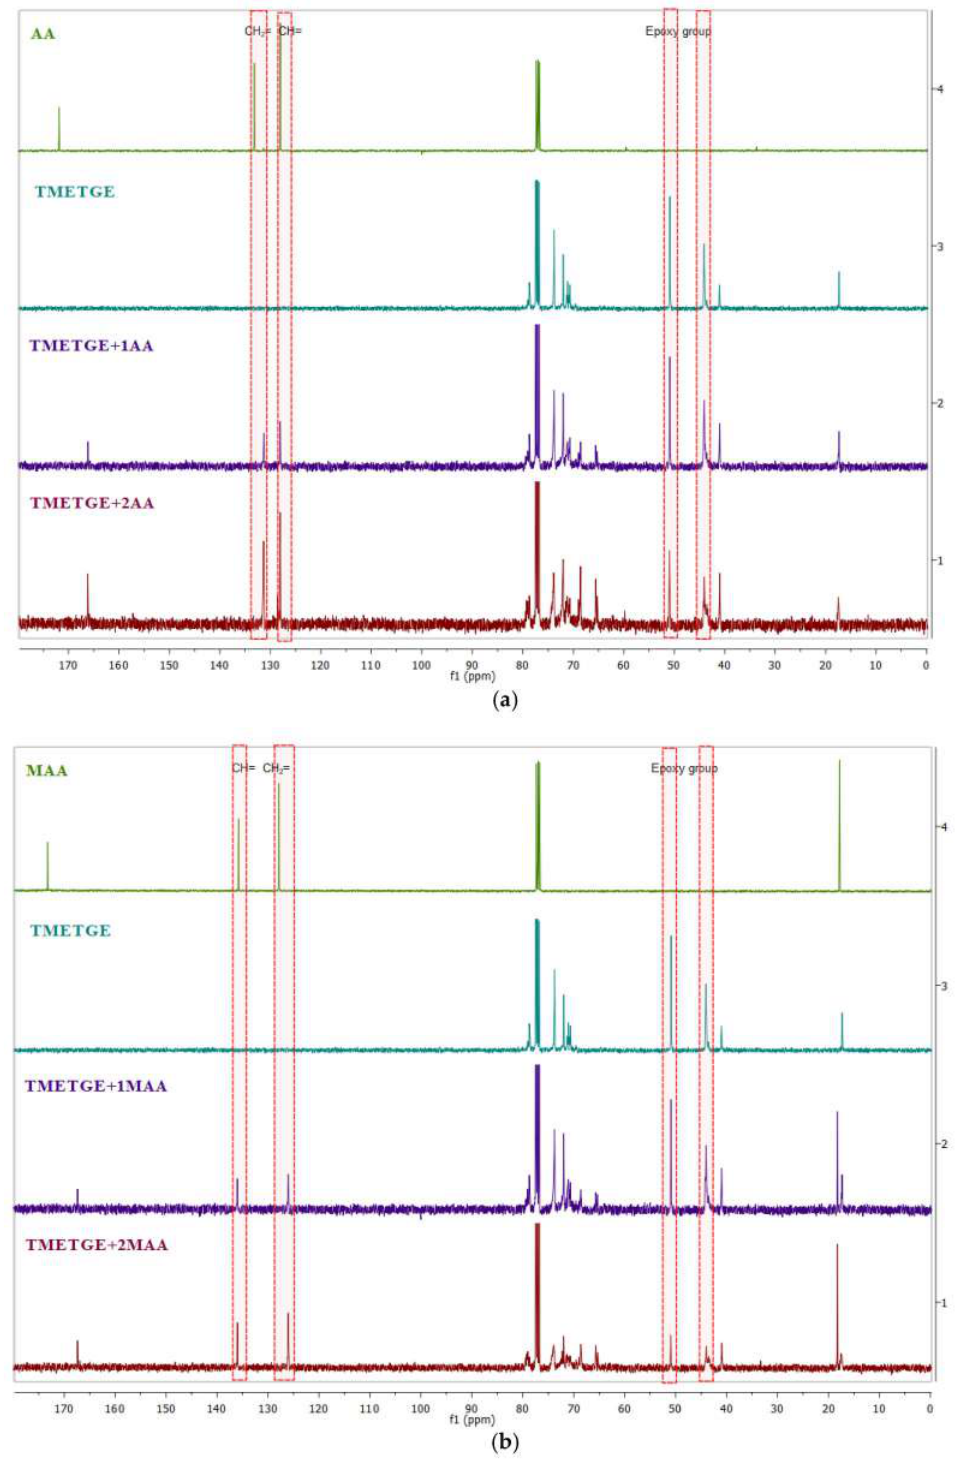
Figure 7. 13 C NMR spectra (CDCl 3 ) of ( a ) AA, triglycidyl ether of trimethylolethane, TMETGE + 1AA, and TMETGE + 2AA (from the top) and ( b ) MAA, triglycidyl ether of trimethylolethane, TMETGE + 1MAA, and TMETGE + 2MAA (from the